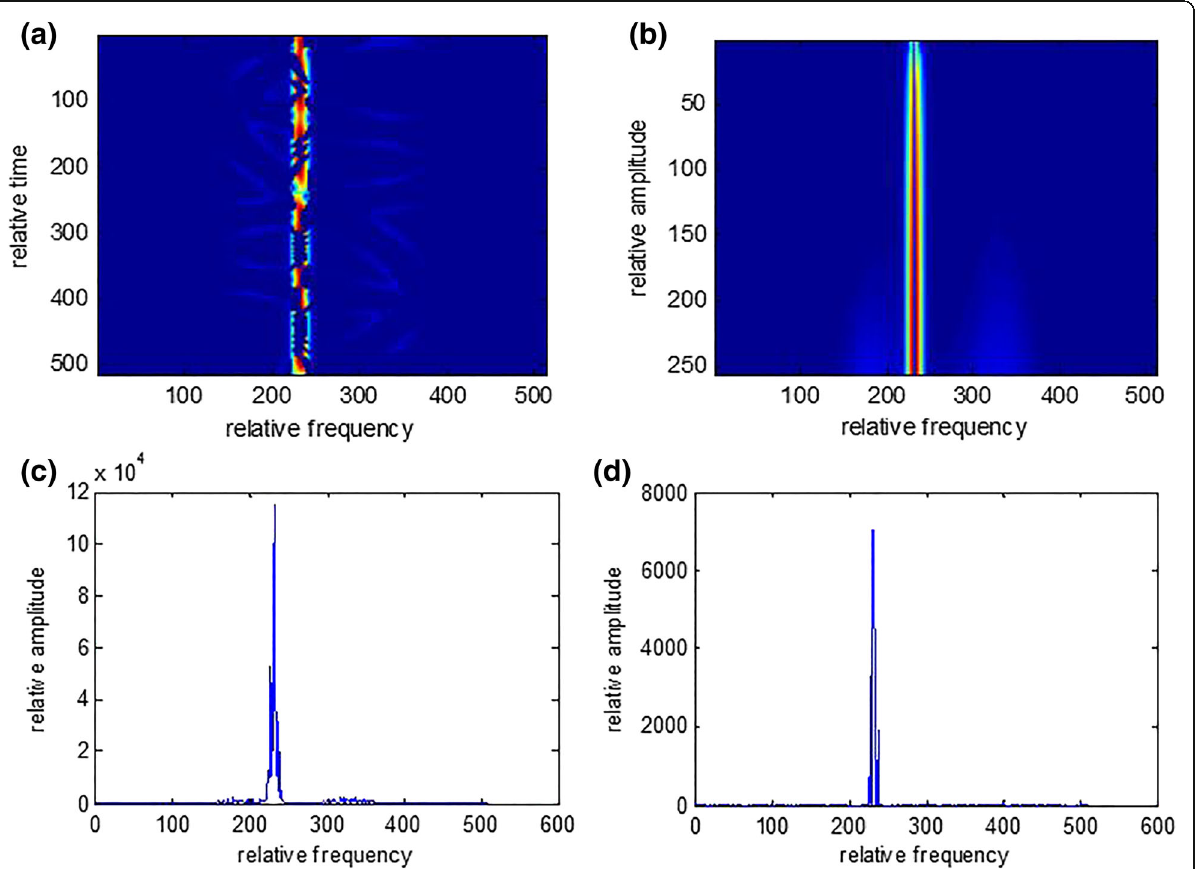
Fig. 5 Signal model simulation results of the proposed algorithm. a STFT of the signal after m-D removal in Section 4.1. b STFT of the signal after m-D removal with the proposed algorithm. c Reconstructed FFT in Section 4.1. d Reconstructed FFT with the proposed